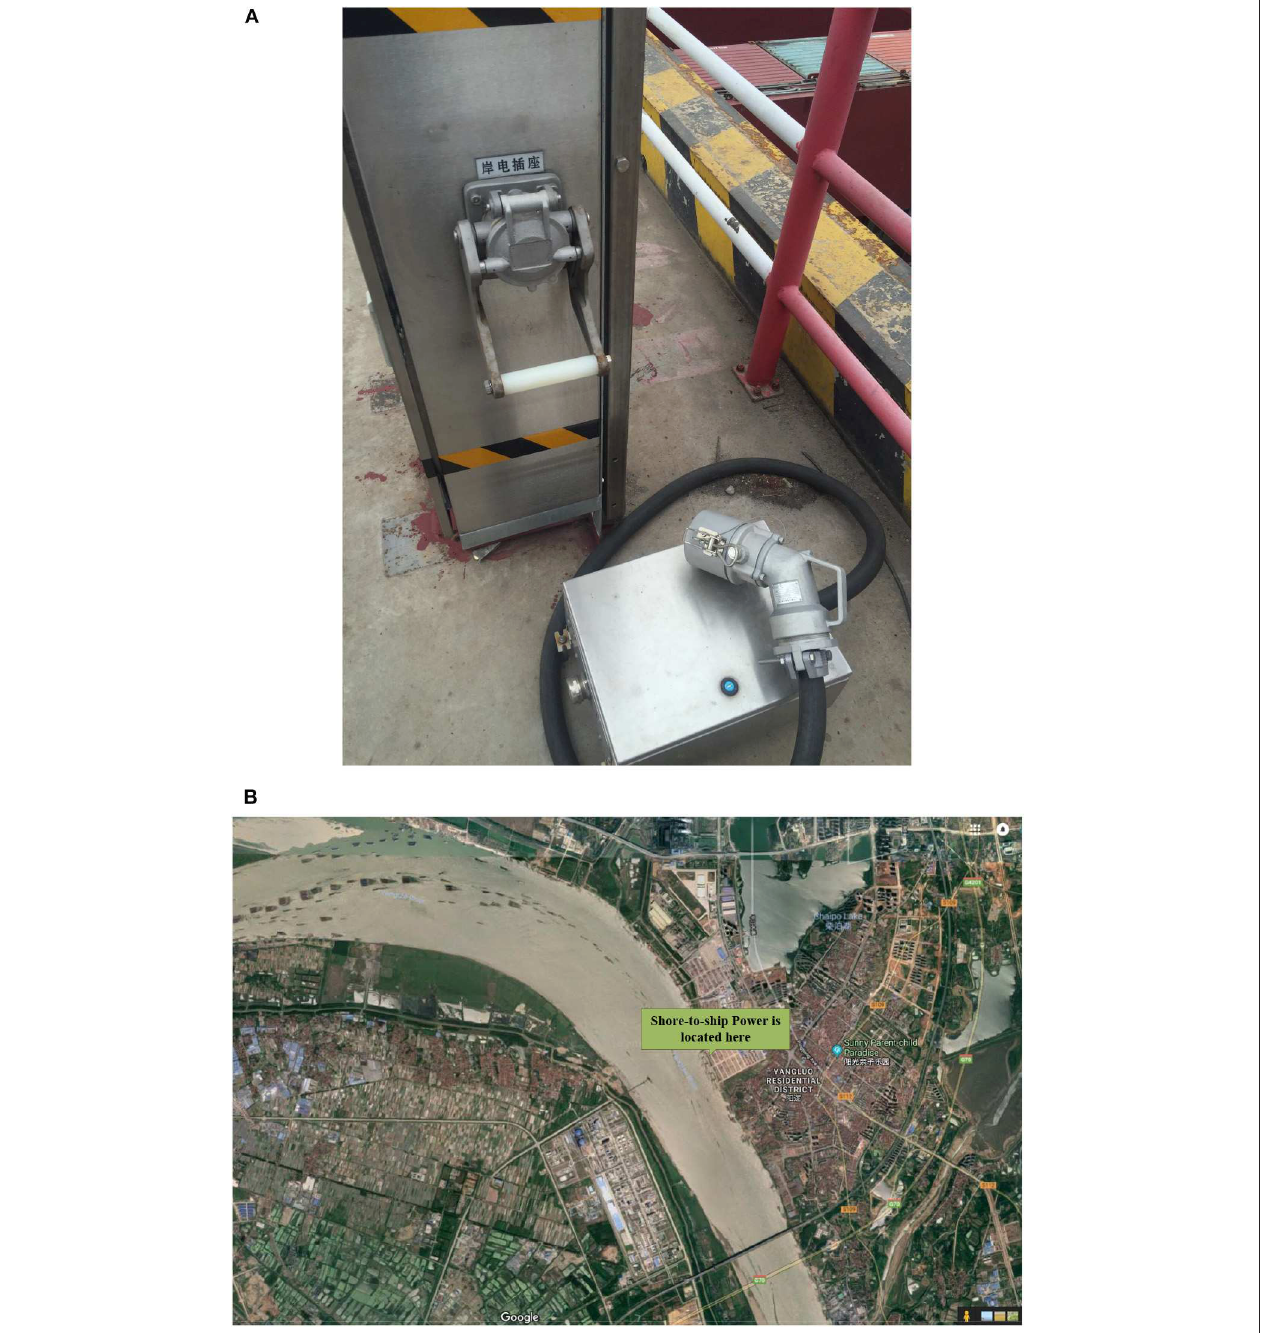
FIGURE 4 | Shore-to-ship power charging piles (China Shanghai FEED POWER Power Supply Technology Co., Ltd.) and a map of their location beside the Yangtze River. (A) Shore-to-ship power charging piles set up by China Shanghai FEED POWER Power Supply Technology Co., Ltd. with no cable lifting device and connection system. (B) The shore-to-ship power charging piles are located in Yangluo Port Container Terminal, Wuhan city.